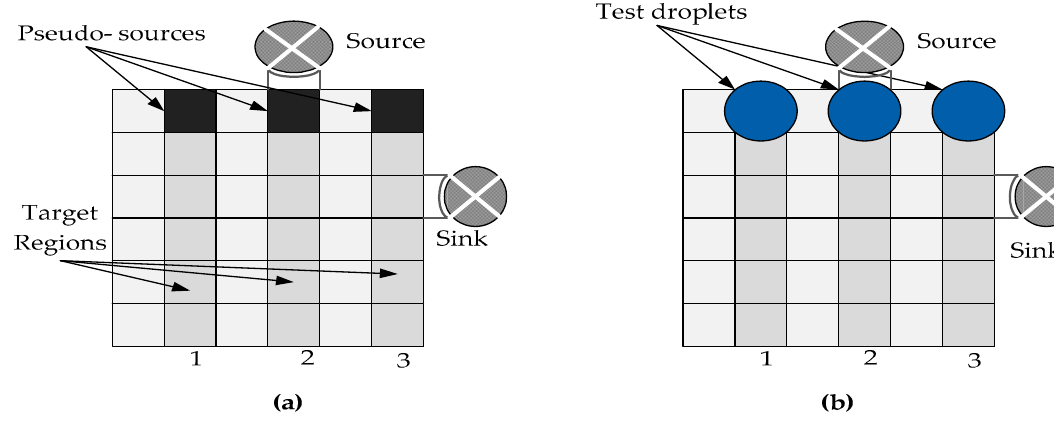
Figure 3. Parallel scan like testing in DMFB ( a ) Test droplets are dispensed from the source to the start electrodes known as pseudo-sources. ( b ) An example of test droplets traversing parallel in the columns of electrodes array [27].